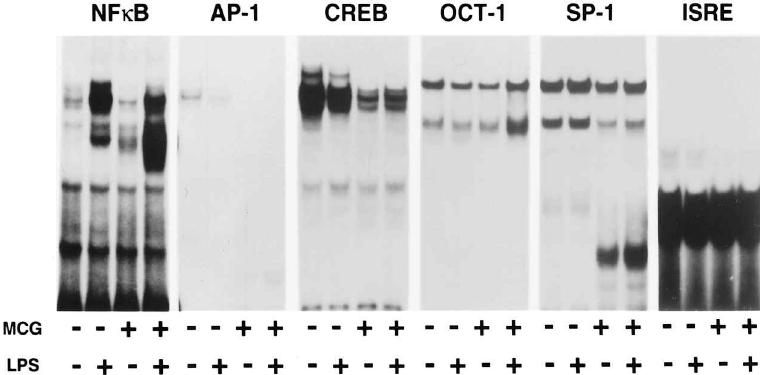
FIG. 4. Effect of MCG phagocytosis on the DNA-binding activities of various transcription factors. J774 cells were incubated for 3h at 37°C without (lanes 1 and 2) or with (lanes 3 and 4) MCG at J774 cell to mast cell ratio of 5 to 1. They were then incubated for an additional 30min at 37°C with (lanes 2 and 4) or without (lanes 1 and 3) LPS (10ng/ml). Nuclear extracts prepared at the end of the incubation period were then subjected to EMSA using 32 P-labelled oligonucleotides specific for NF- k B, AP-1, CREB, Oct-1, SP-1 or ISRE. An additional experiment gave a similar results to that